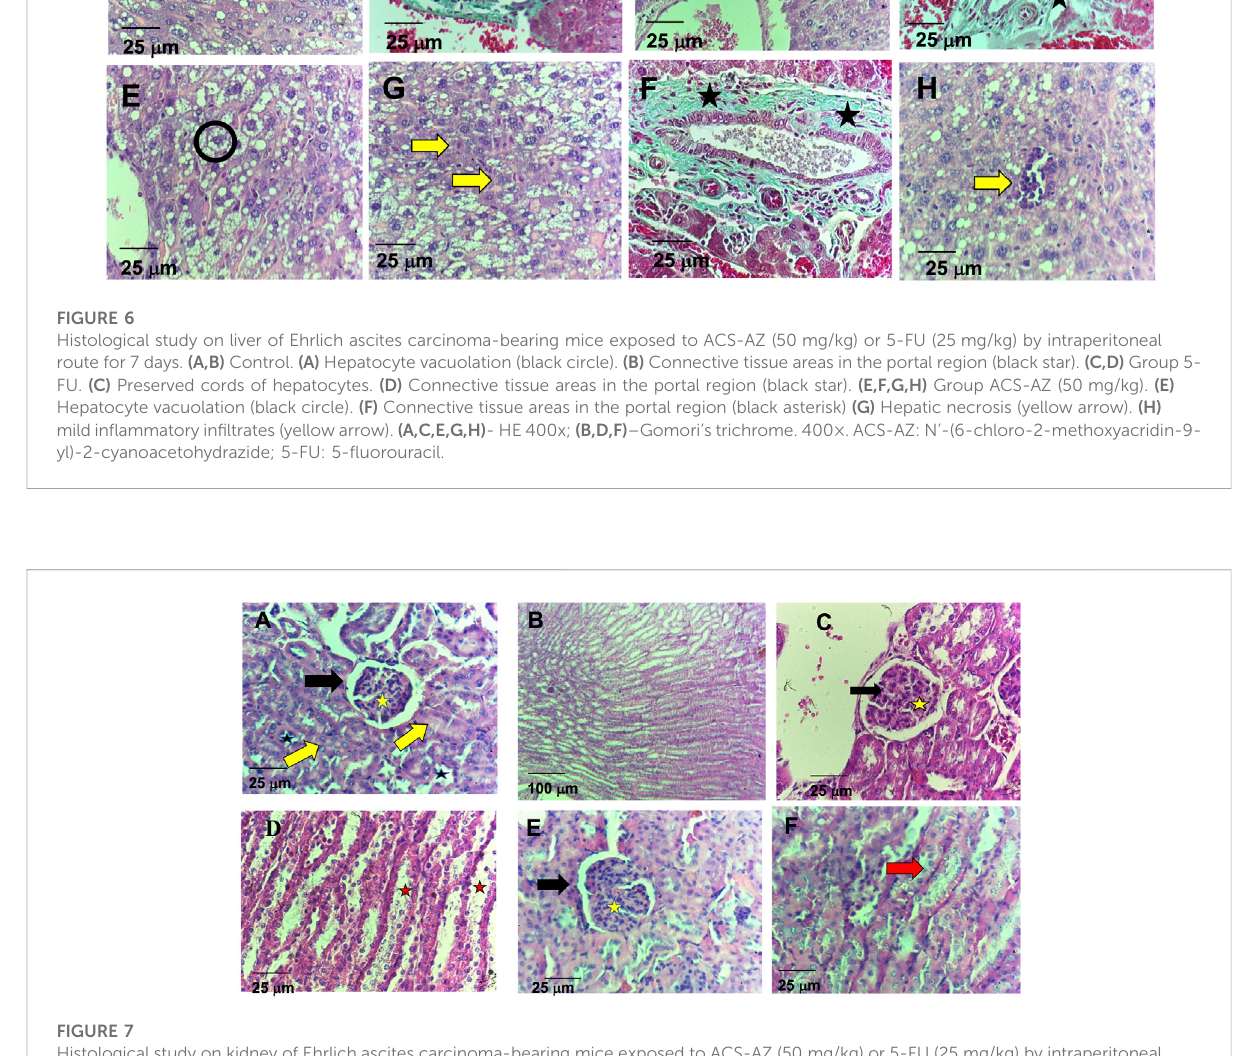
FIGURE 7 Histological study on kidney of Ehrlich ascites carcinoma-bearing mice exposed to ACS-AZ (50 mg/kg) or 5-FU (25 mg/kg) by intraperitoneal route for 7 days. (A,B) Control. (A) Preserved renal cortex with glomerulus surrounded by Bowman ’ s capsule (black arrow) with internal capillary tuft (yellow star), proximal (yellow arrow), and distal (black star) tubules. (B) Preserved collecting ducts in the renal medulla. (C,D) Group 5-FU. (C) In the renal cortex, conserved glomeruli (black arrow) and tubules (yellow star). (D) Visible light in the medullary region (red star). (E,F) Group ACS-AZ (50 mg/kg). (E) Conserved renal cortex with glomerulus surrounded by Bowman ’ s capsule (black arrow), internal capillary tuff (yellow star), and proximal and distal tubules. (F) Conserved tubular epithelium (red arrow). (A,C,D,E,F) HE, 400×; (B) HE, 100x. ACS-AZ: N ’